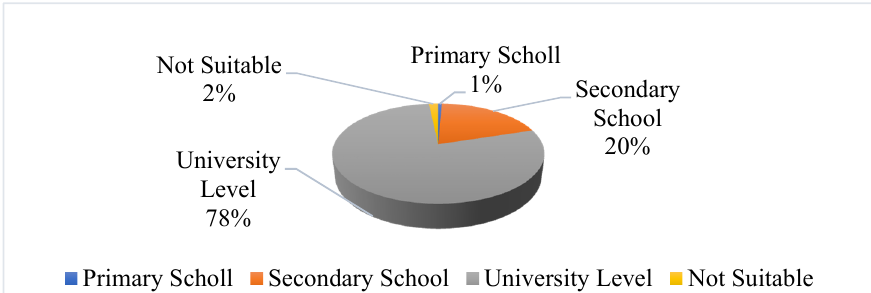
Figure 1. Level for introducing tax subjects.